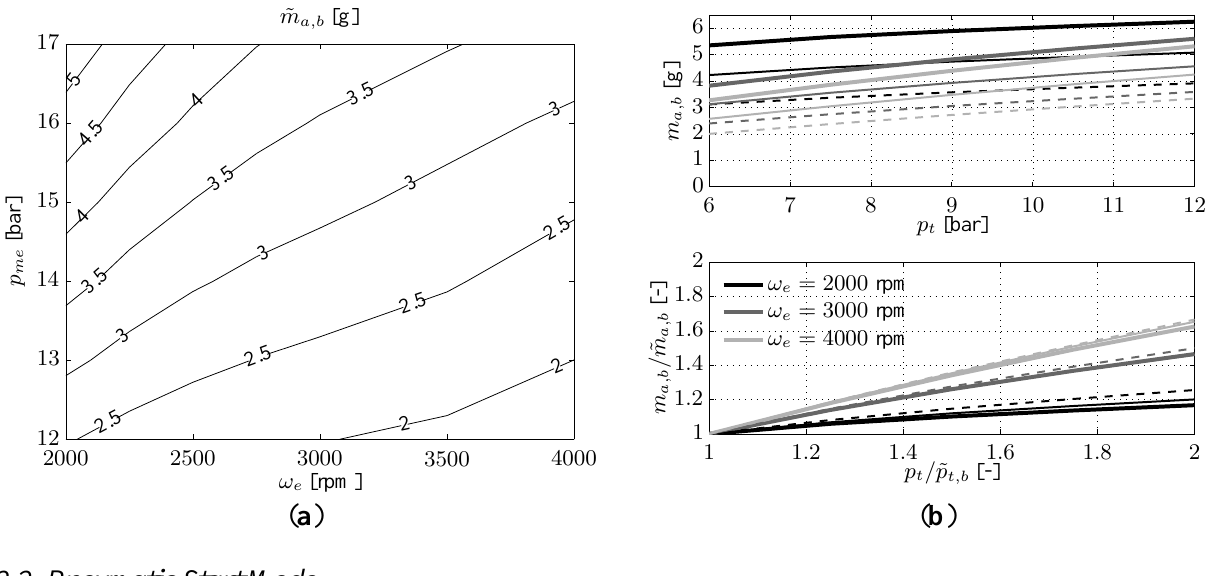
Figure 2. ( a ) Nominal air demand ˜ m to various torques at various engine speeds with p various tank pressures: Dashed: p p = 17 bar . CV size used µ me